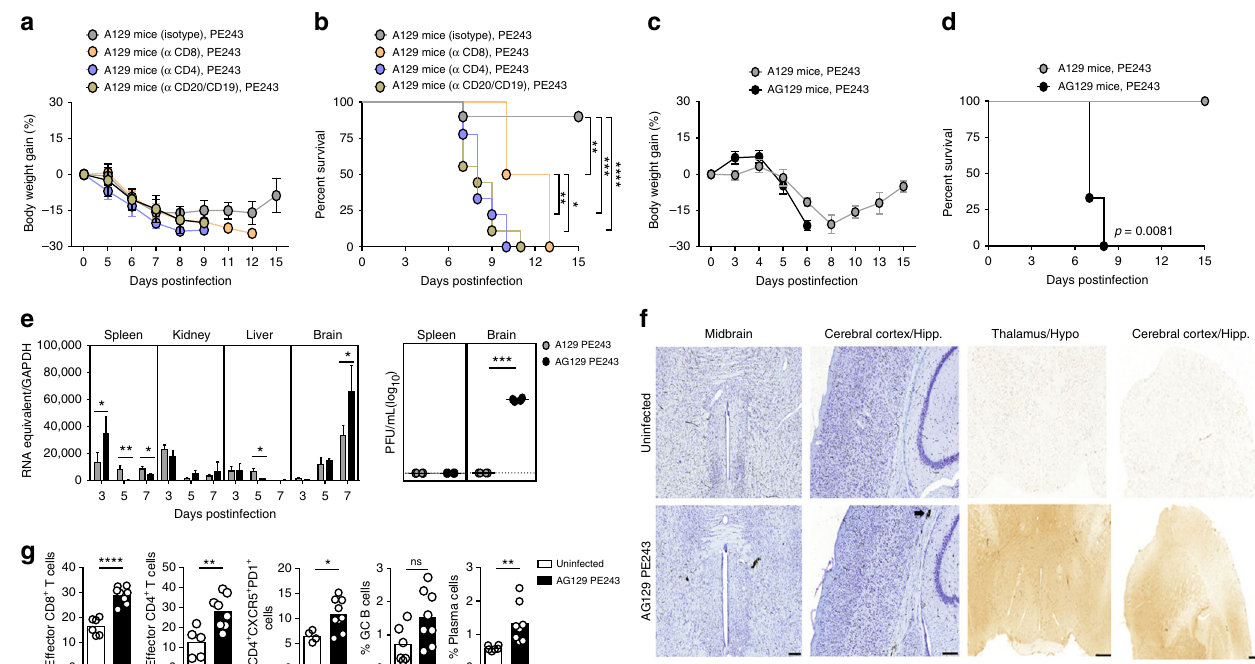
Fig. 3 Lymphocytes and IFN γ signaling are required in the resistance to ZIKV PE243. Four-week-old A129 or AG129 mice were inoculated intravenously with 2 × 10 5 PFU of ZIKV PE243. a Body weight gain and b lethality of A129 mice previously depleted of CD8 + ( n = 4), CD4 + T cells ( n = 9), or B cells ( n = 9) infected, and monitored for up to 15 days postinfection. Control mice received IgG2a isotype control ( n = 10). c Body weight gain and d lethality of infected AG129 mice ( n = 11) compared to A129 mice ( n = 10). e ZIKV RNA copies in the spleen, kidney, liver, and brain postinfection of A129 ( n = 4 – 6) or AG129 mice ( n = 3 – 4), and infectious particles of ZIKV in the spleen and brain at 7 days postinfection, determined, respectively, by qRT-PCR and plaque assay. The horizontal dotted line indicates the limit of detection. f Representative photomicrographs of DAB-stained (Scale bar: 200 μ m) or IgG-stained (Scale bar: 500 μ m) brain sections retrieved from uninfected AG129 mice ( n = 3) or AG129 mice at day 7 postinfection with ZIKV PE243 ( n = 3). The arrow points to a focus of microhemorrhage in the white matter while IgG stains in brown. g Frequency of effector CD8 + T cells or CD4 + T cells, CD4 + CXCR5 + PD-1 + cells, germinal center B cells and plasma cells in the spleen of infected AG129 mice ( n = 8) at day 7 postinfection, compared to uninfected AG129 mice ( n = 5 – 6). Results are shown as mean in g and e or as mean ± standard deviation in a , c , and e . Data are presented as a pool of two ( a , b , and g ) or three ( c and d ) independent experiments, experiments were performed once in e and f . Survival data were analyzed by log rank test. Data were analyzed by Student ’ s t test in e and g . (*) p ≤ 0.05; (**) p ≤ 0.01; (***) p ≤ 0.001; (****) p ≤ 0.0001; ns not signi fi cant; Hypo hypothalamus;